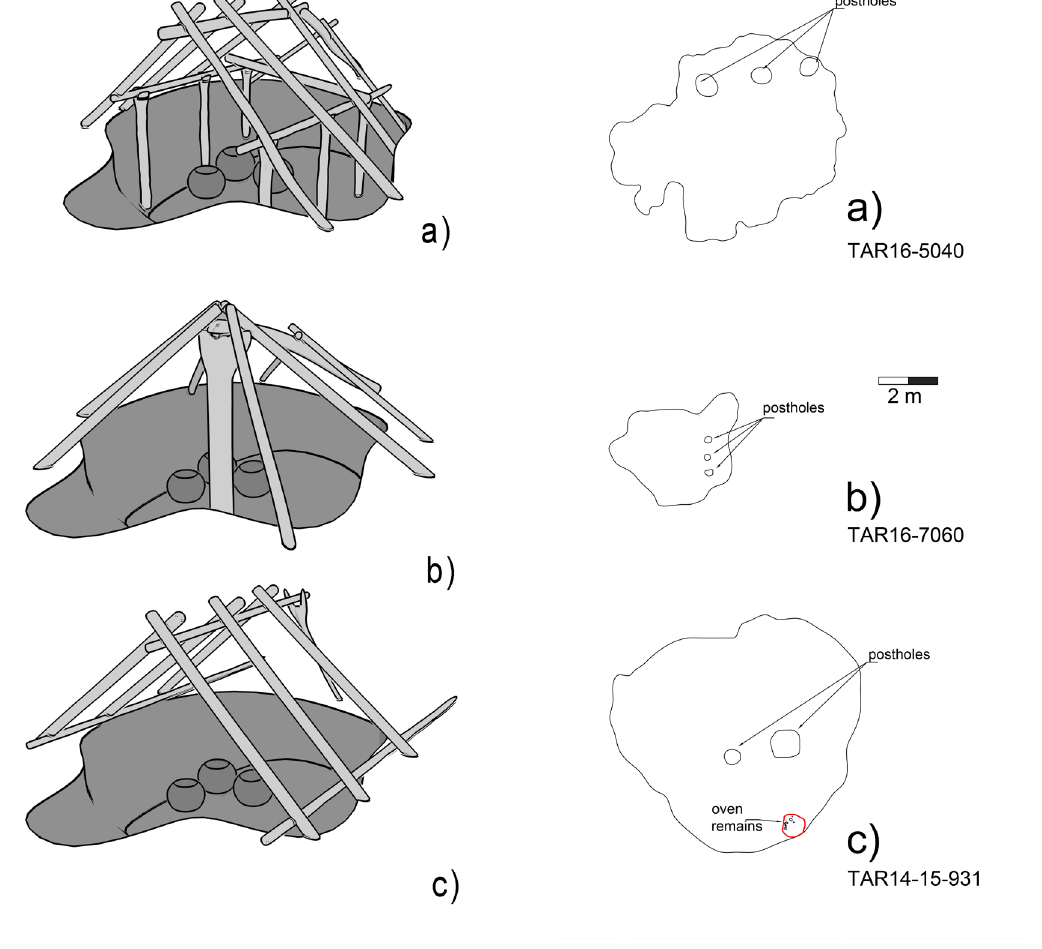
Figure 7: Different types of a roof construction: a) with inside pillars in a line b) with one central pillar c) with the roofing based on a ground level.